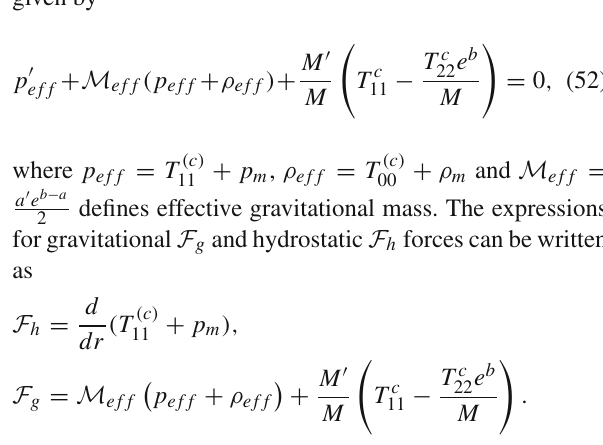
fied GB gravity. In both plots, the positively decreasing (left) and increasing (right) curves show that f G > 0 and f GG > 0 implying consistency with viable GB models. Figure 10 elab- left plot, positively decreasing curve follows asymptotically flat shape as r → ∞ . The right plot locates WH throat